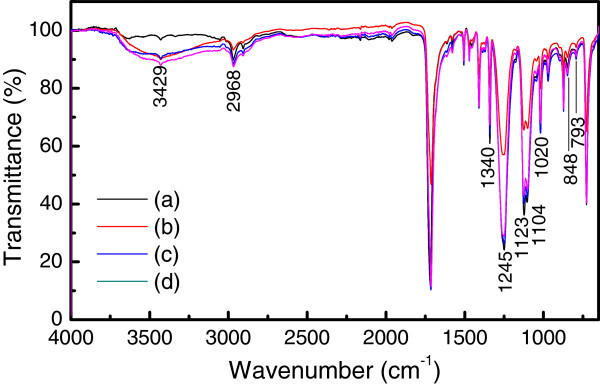
FTIR spectra. (a) Uncoated PET, the Al2O3-coated PET films by (b) ALD, (c) ALD with plasma pretreatment, and (d) PA-ALD.